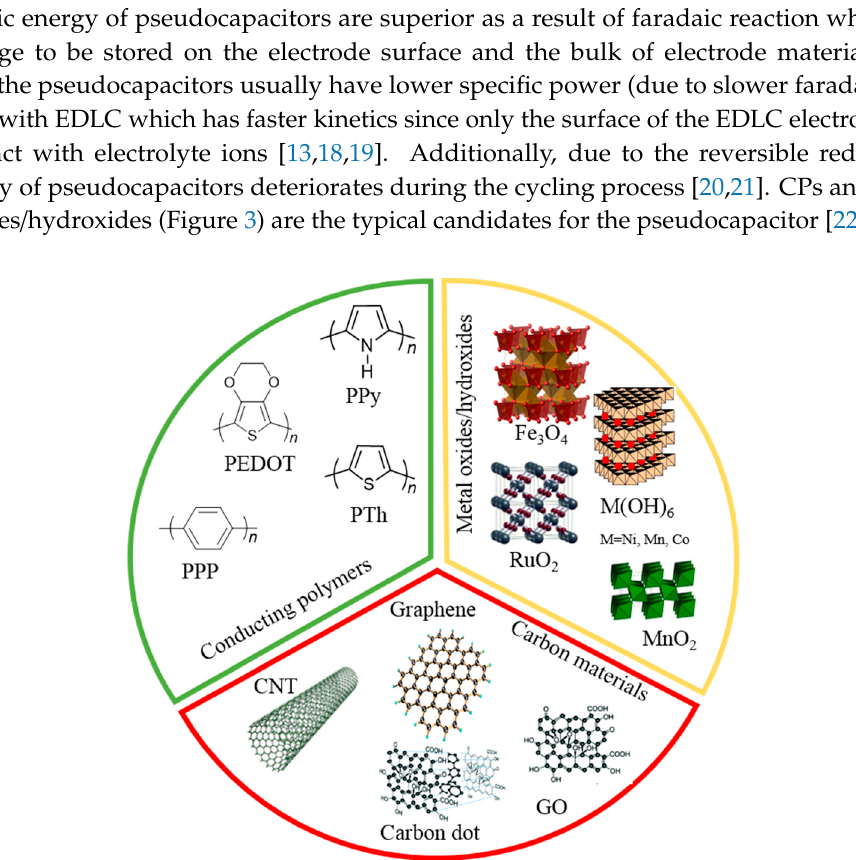
Figure 3. Schematic diagram of three different types of materials used as supercapacitor electrodes: CPs, carbon materials, and transition metal oxides/hydroxides.